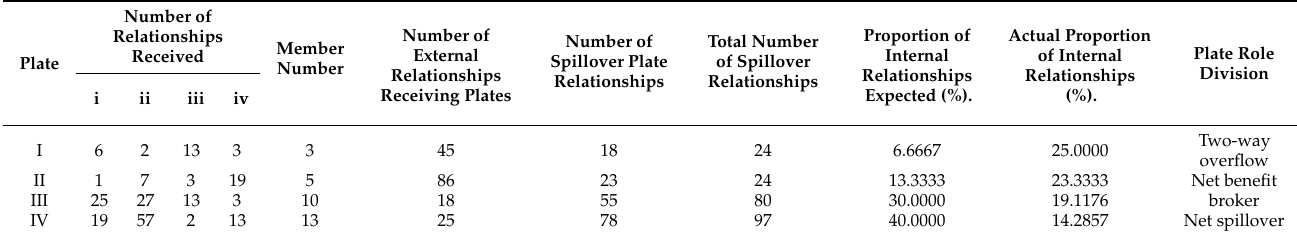
Table 7. Analysis of spillover effects of each section of the spatial correlation